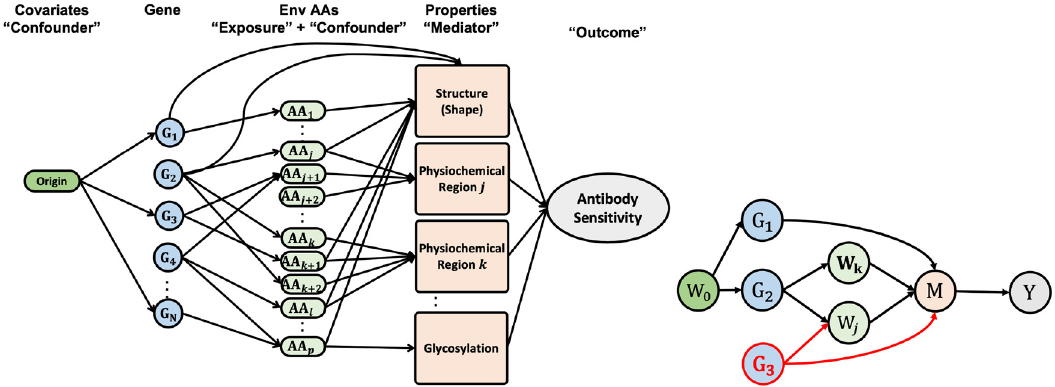
Figure 3: DAG for HIV resistance. The DAG on the left shows a pipeline of gene expression, which de fi nes how gene regulates downstream activities and further a ff ects the antibody sensitivity through Envelope AAs of